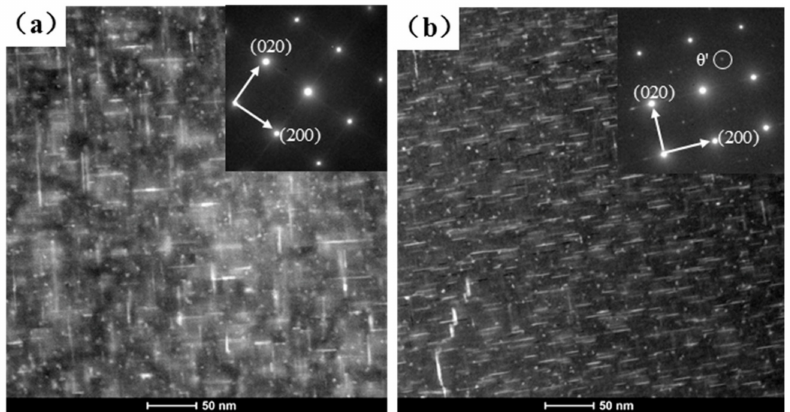
Figure 15. {001} Al TEM images of the as-aged samples with cold bulging at different ratios: ( a ) With- out cold bulging and ( b ) with 2% cold